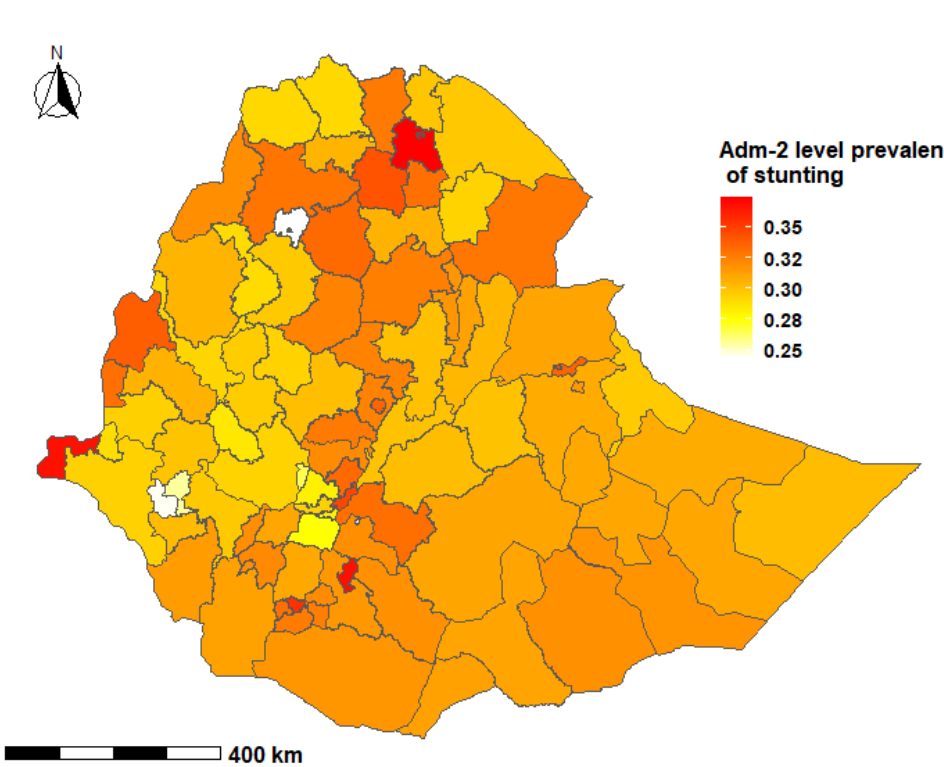
Figure 3. Second administrative level prevalence of stunting among children 0–23 months of age in Ethiopia, EDHS 2016.